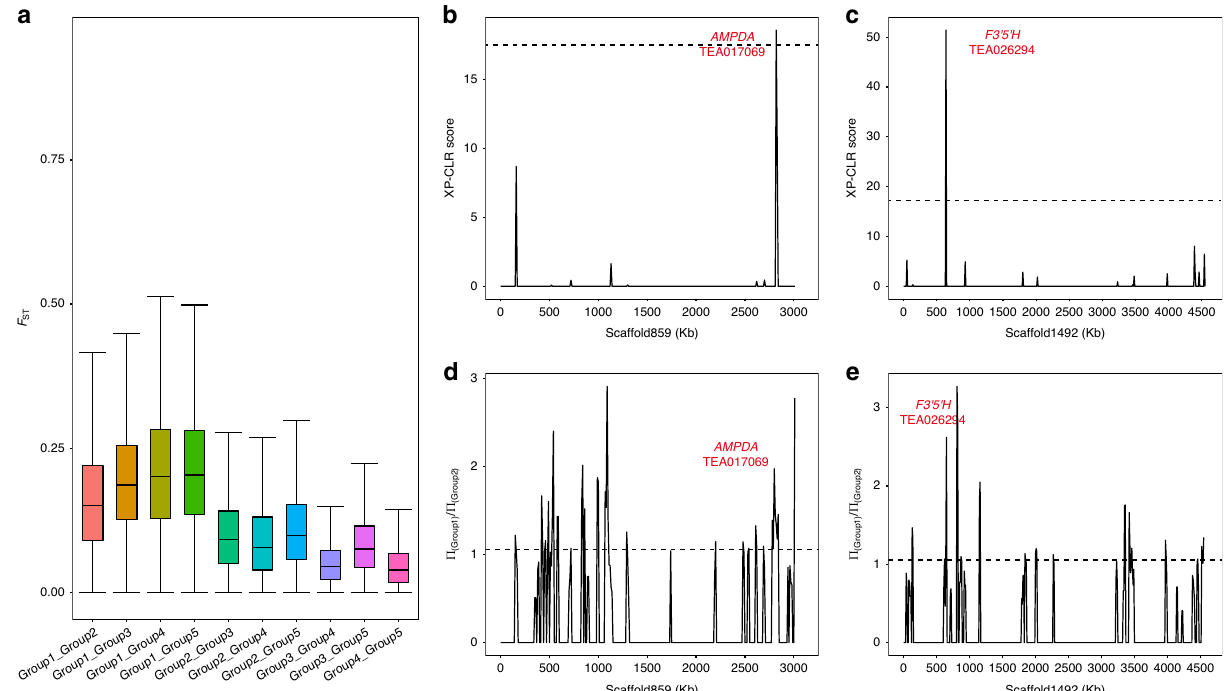
Fig. 3 Population differentiation and selective sweep regions across fi ve groups of tea plant accessions. a Boxplot of Fst values calculated from pairwise comparisons of fi ve groups of tea plant accessions (identi fi ed in Fig. 1a). Fst was calculated on 100 kb sliding windows with a step size of 10 kb along all scaffolds in the tea reference genome. ( n = 180,916, 181,969, 182,127, 182,256, 181,842, 181,136, 181,436, 181,989, 182,235, 181,300 sliding windows for plots ordered from left to right). Boxes = interquartile ranges, middles = medians, whiskers = 1.5 × the interquartile range. b – e Plot of selective sweep ( b , c ) and nucleotide diversity values ( d , e ) along scaffold859 and scaffold1492 that contain selective sweep regions. The dotted line in b , c indicates a threshold value of 18.40 and the dotted line in d , e indicates a threshold value of 1.054. Source data are provided as a Source Data fi (Fig. 1b). We identi fi ed 833 potential selective sweep regions that contained 1132 genes. Fig. 3b – e. A selective sweep region on scaffold859 contained the AMPDA gene (TEA017069, encoding an adenosine monopho-